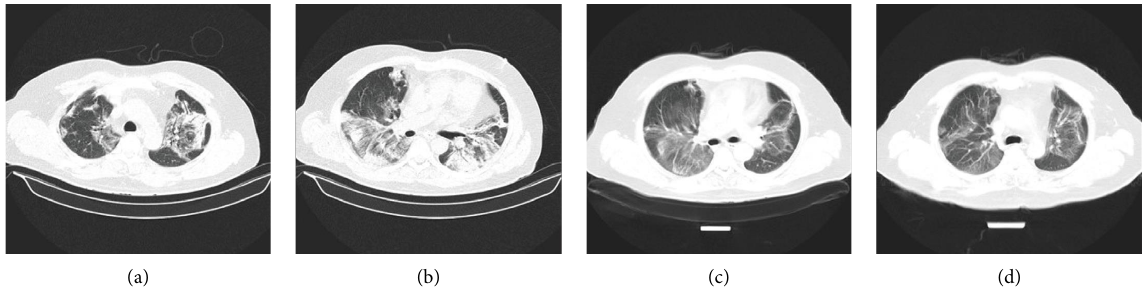
Figure 1: A 51-year-old man with COVID-19 pneumonia with a 17/25 severity score receiving remdesivir and dexamethasone for treatment. (a, b) Te axial chest CTscan depicts air space opacities with predominant consolidation. (c, d) Chest CT 8weeks after hospital discharge demonstrates residual faint ground-glass opacities and subsegmental atelectasis.